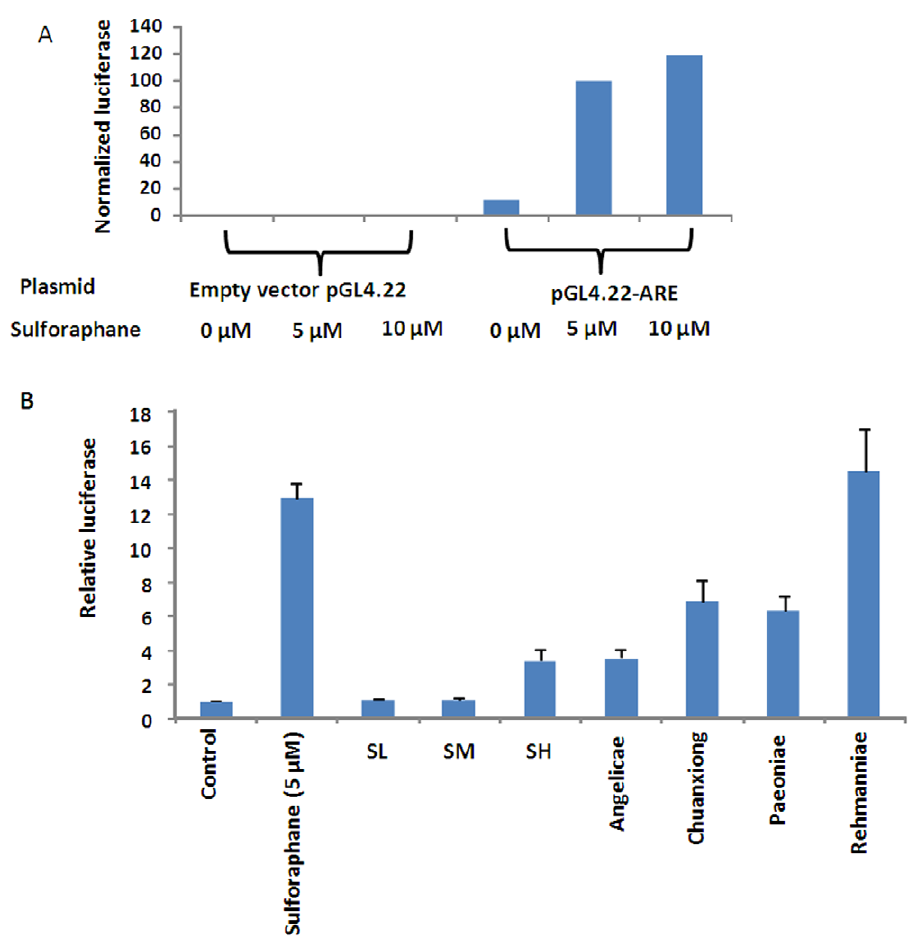
Figure 5. Luciferase assay results. (A) Luciferase assay established using HEK-293 cells co-transfected with a plasmid containing an ARE-luciferase reporter gene (pGL4.22-ARE) or empty vector (pGL4.22) and a plasmid encoding renillar luciferase (pGL4.74). The transfected cells were treated with sulforaphane for 24 hr prior to measurement of firefly and renillar luciferase activities using the dual luciferase reporter gene assay. (B) SWT (three doses SL, SM and SH in 0.0256, 0.256 and 2.56 mg/ml) and four herbal components of SWT (2.56 mg/ml) activated the Nrf2/ARE signaling pathway in MCF-7 cells.